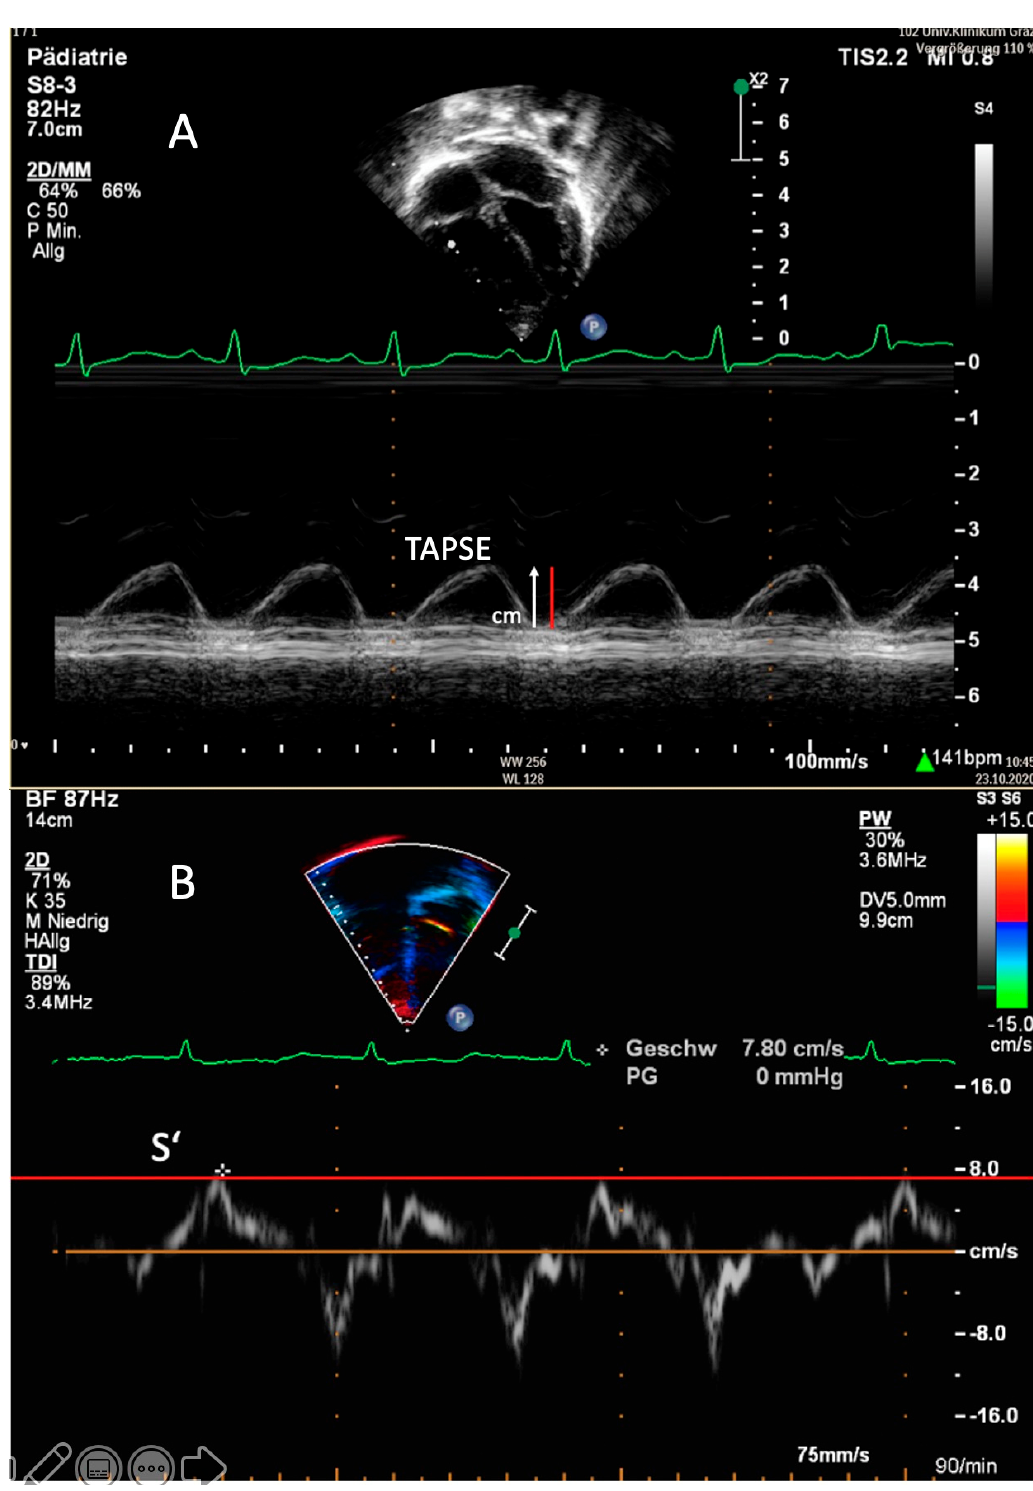
Figure 2. Transthoracic imaging. ( A ) Apical four-chamber view. Determination of the tricuspid annular plane systolic excursion (TAPSE) in a 1-year-old patient with idiopathic pulmonary arterial hypertension in M-mode. The red line demonstrates a TAPSE value that is abnormally low in this patient (1.1 cm; z-score − 3). ( B ) Apical four-chamber view. Right, ventricular tissue Doppler imaging (TDI) with the PW curser placed at the lateral tricuspid annulus in an 8-year-old patient with pulmonary arterial hypertension associated with congenital heart disease (PAH-CHD). In this patient, the values of the tricuspid peak systolic excursion (S’) are reduced, depicted as the red